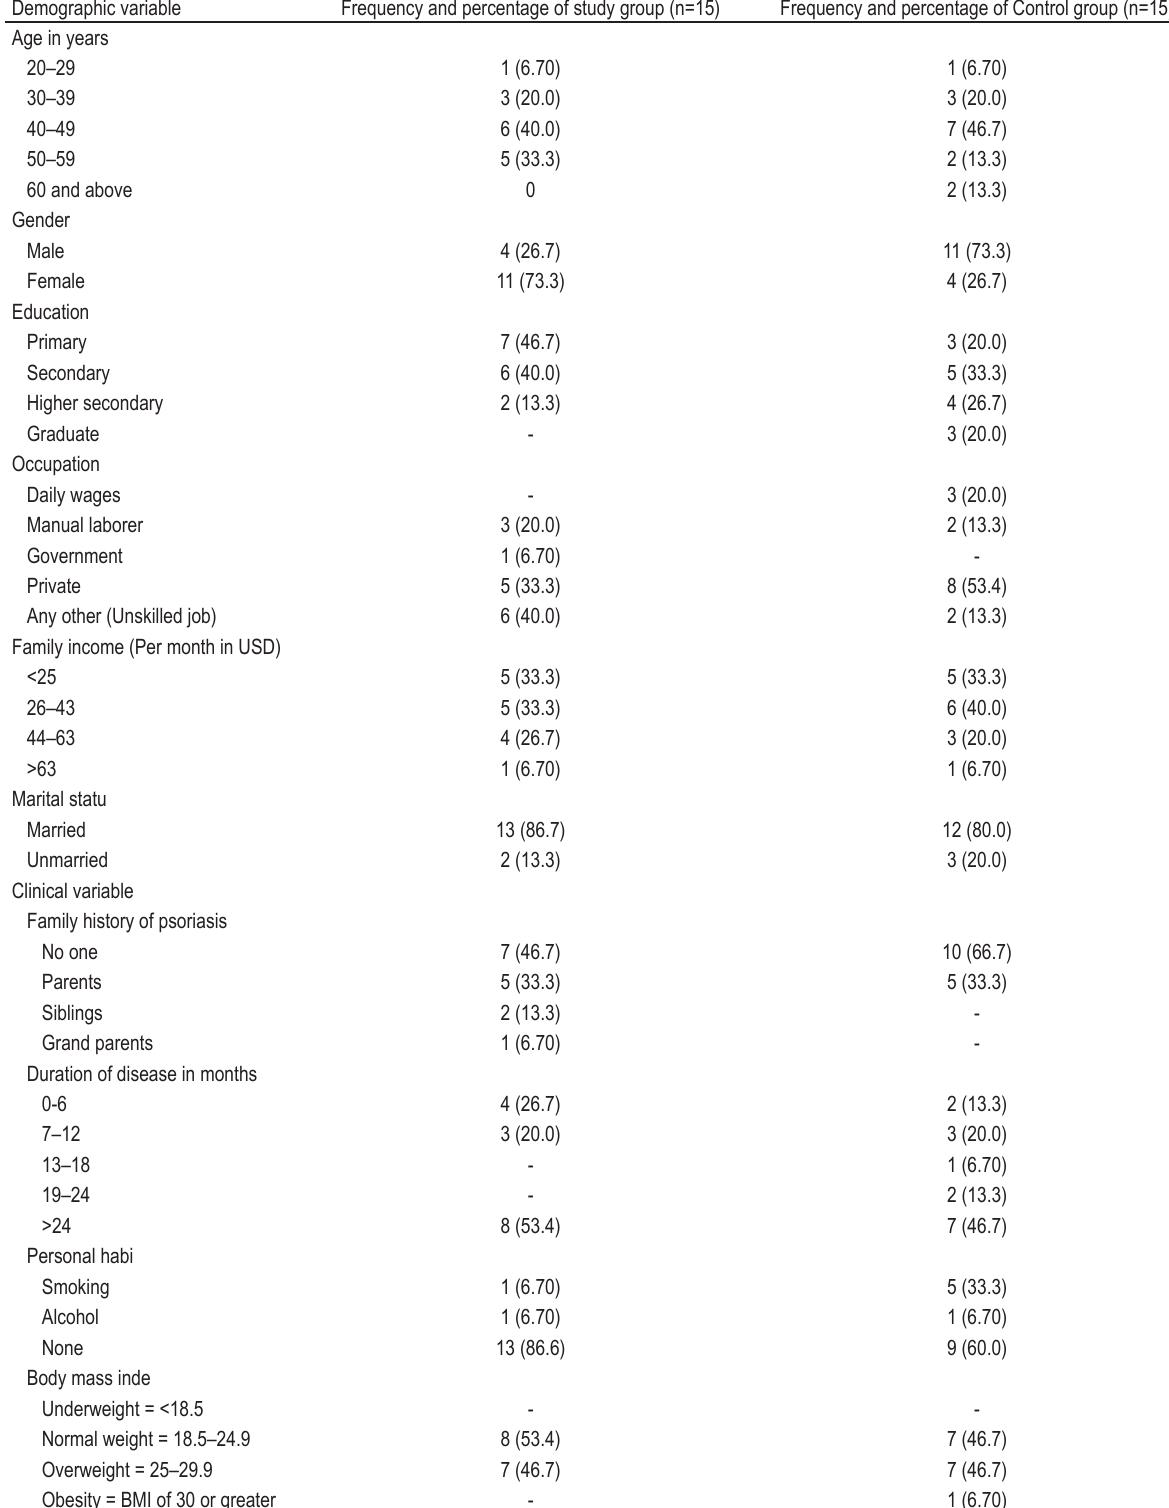
TABLE 2. Frequency and percentage of distribution of demographic and clinical variables among study and control group (n=30) Demographic